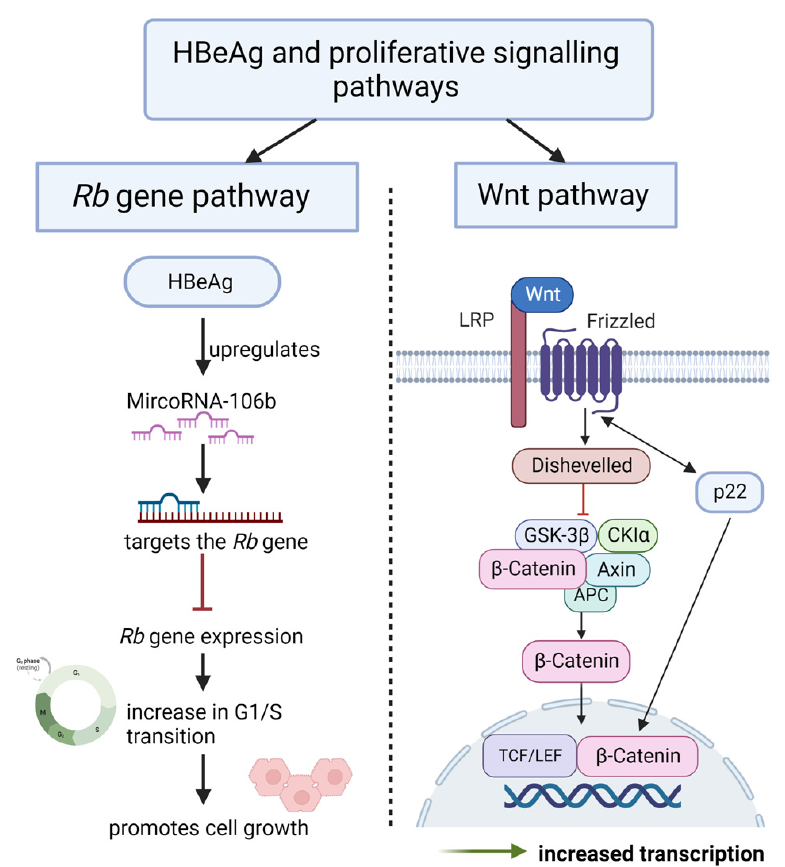
Figure 5. Role of HBeAg in proliferative signalling pathways: the role of the HBeAg Rb gene pathway and the wnt signalling pathway. Rb gene pathway—HBeAg upregulates miR-106b, which targets the Rb gene. Thus, reducing Rb gene expression, resulting in a promotion of progression from the G0/G1 phase into the S phase of the cell cycle in Huh7 cells, adapted with permission from [162], Scientific reports (http://creativecommons.org/licenses/by/4.0/, accessed on 23 March 2023). Wnt signalling pathway—p22 induces Fzd7 and GLUL and is able to increase TCF/ β -catenin transcription on its own to promote proliferative signalling [155]. Image created using